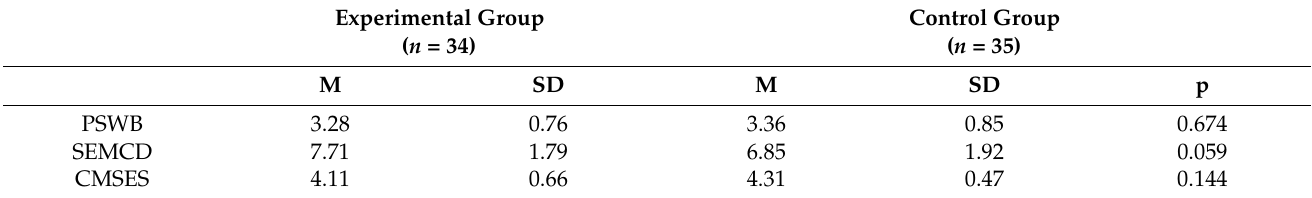
Table 2. Baseline scores in the experimental and the control group in all the outcome